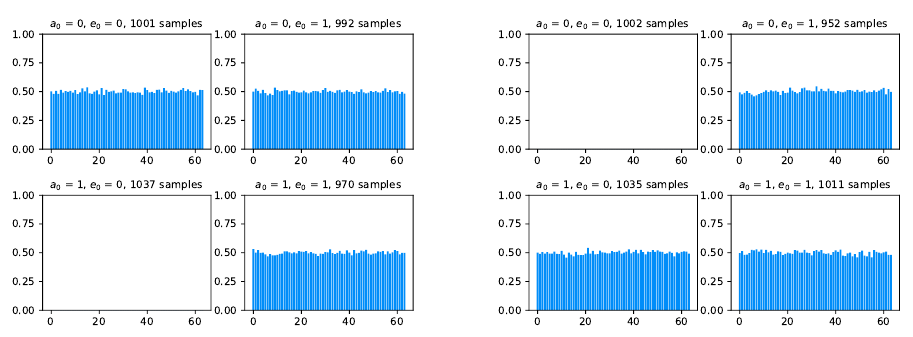
Figure 7: Ratio of 1 values taken by α v,i (left) and α w,i (right) for each output coordinate ( i ∈ { 0 , . . . , 63 } ) and for 4000 capacities chosen uniformly at random, depending on ( a